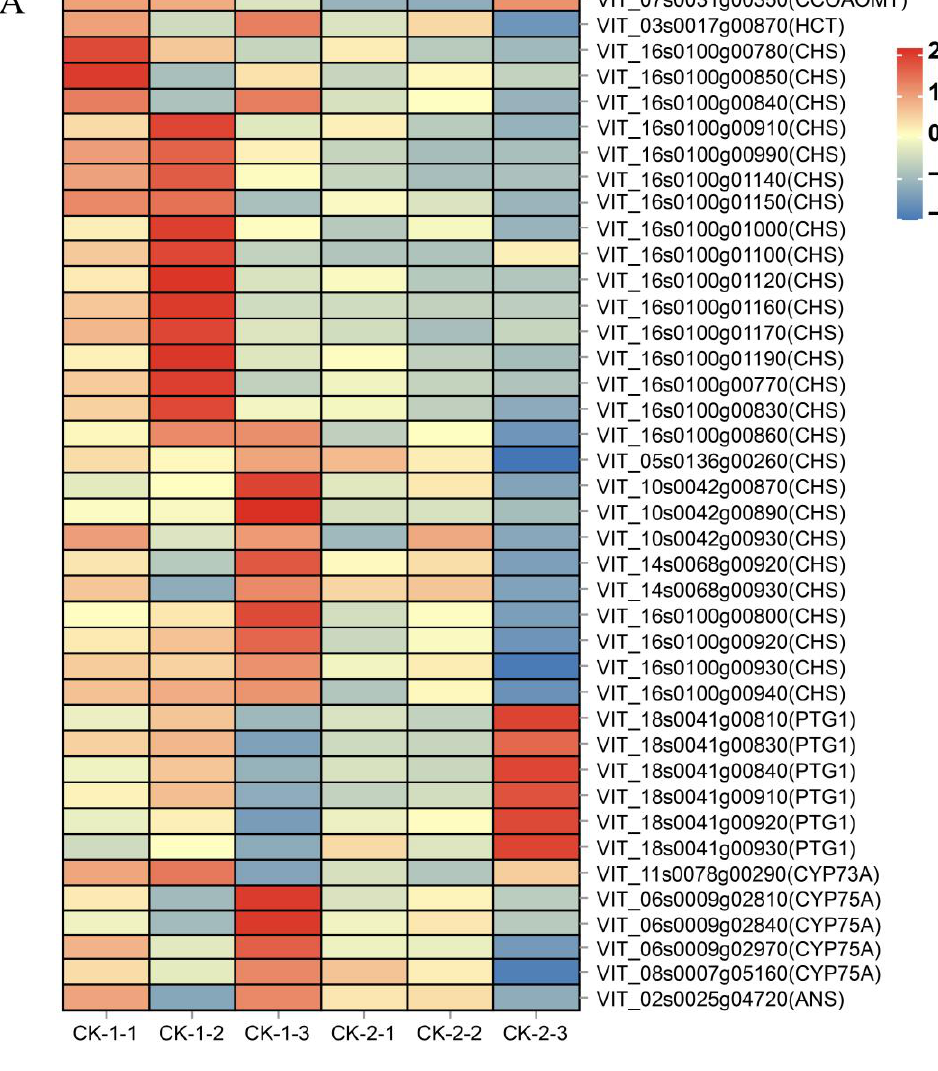
Figure 8. Expression of DEGs related to secondary metabolite synthesis. ( A ): Heatmap of DEGs ex- pression in the flavonoid synthesis pathway under different treatments; ( B ): Expression of common DEGs related to secondary metabolites under different stress times (CK-1-1 vs. CK-1-2 vs. CK-1-3); ( C ): Expression of DEGs related to secondary metabolites under different stress temperatures (CK- 1-1 vs. CK-2-1).